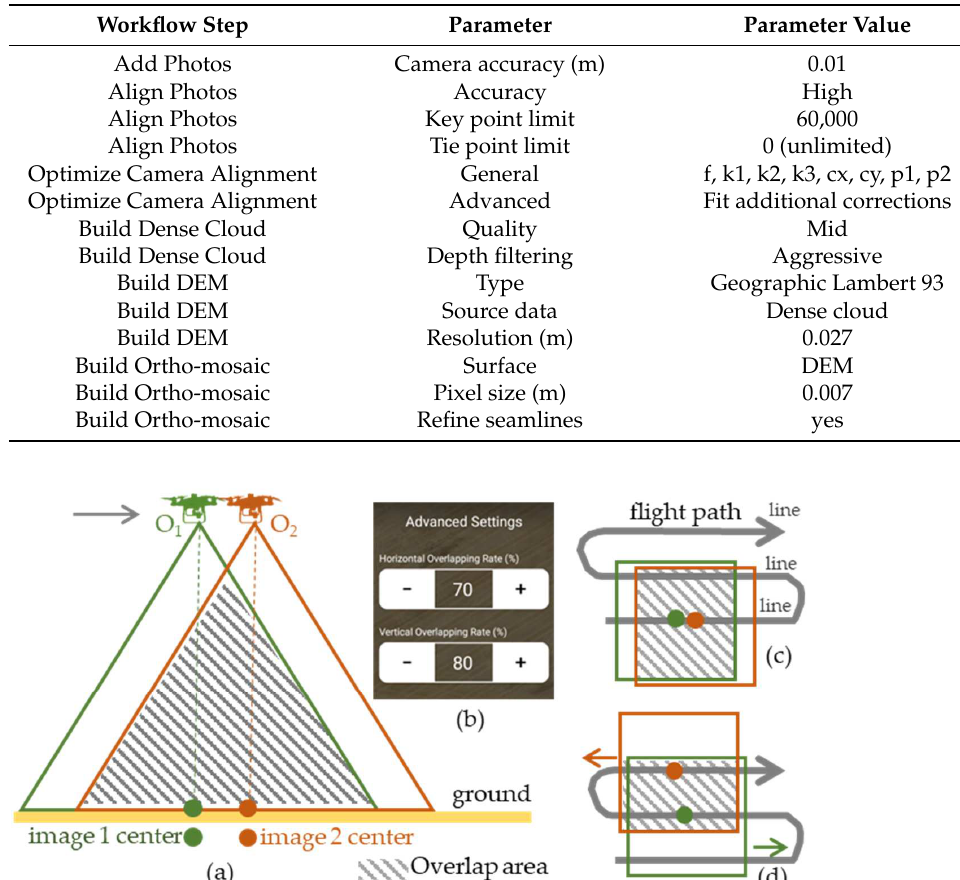
Table 3. The main parameter values for Agisoft Metashape v 1.7.4 reconstructions.